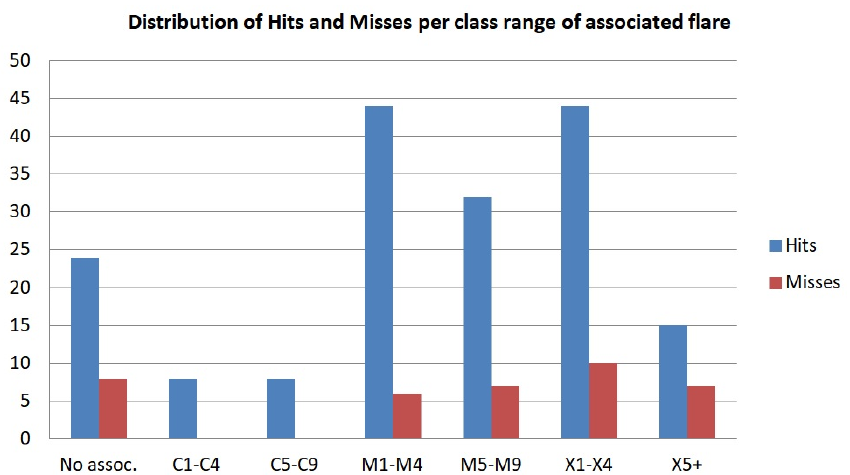
Figure 4. Distribution of hits and misses per class range of the associated flares of all SEP events in Table 1.